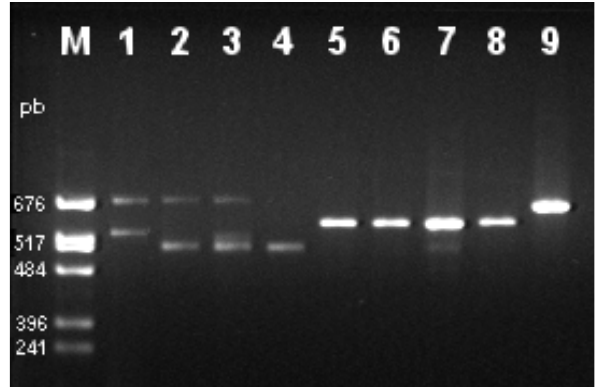
Figura 2. Eletroforese em gel de agarose 1.5 % de DNA, obtido a partir de esporos de FMA, amplificado por PCR. As bandas foram amplificadas utilizando-se os oligonucleotídeos ITS1 e ITS4, respectivamente. M- marcador de